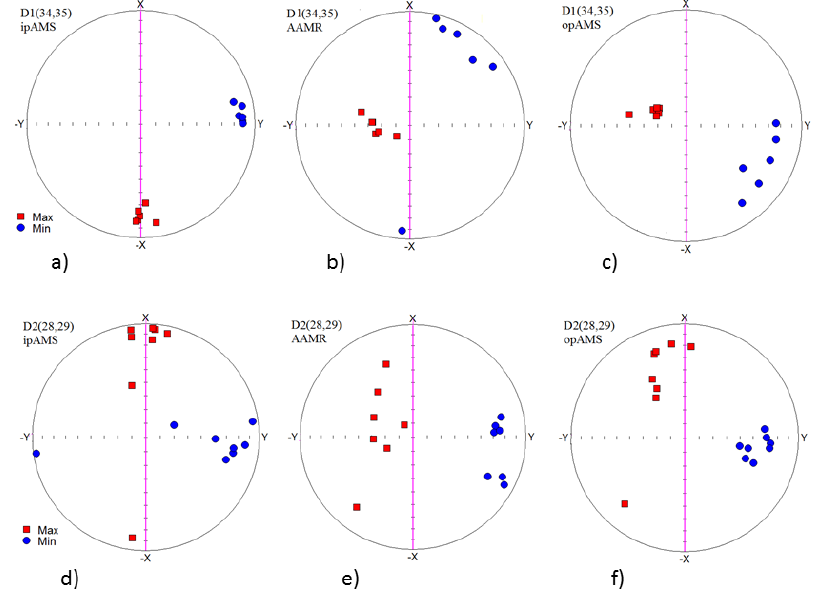
Figure 7. Domains D1 and D2 with normal magnetic fabric ( a , d —anisotropy of the in-phase component of susceptibility, ipAMS; b , e —anisotropy of anhysteretic magnetic remanence, AAMR; c , f —out-of-phase component of susceptibility, opAMS). Dyke coordinate system, equal-area projection on lower hemisphere.